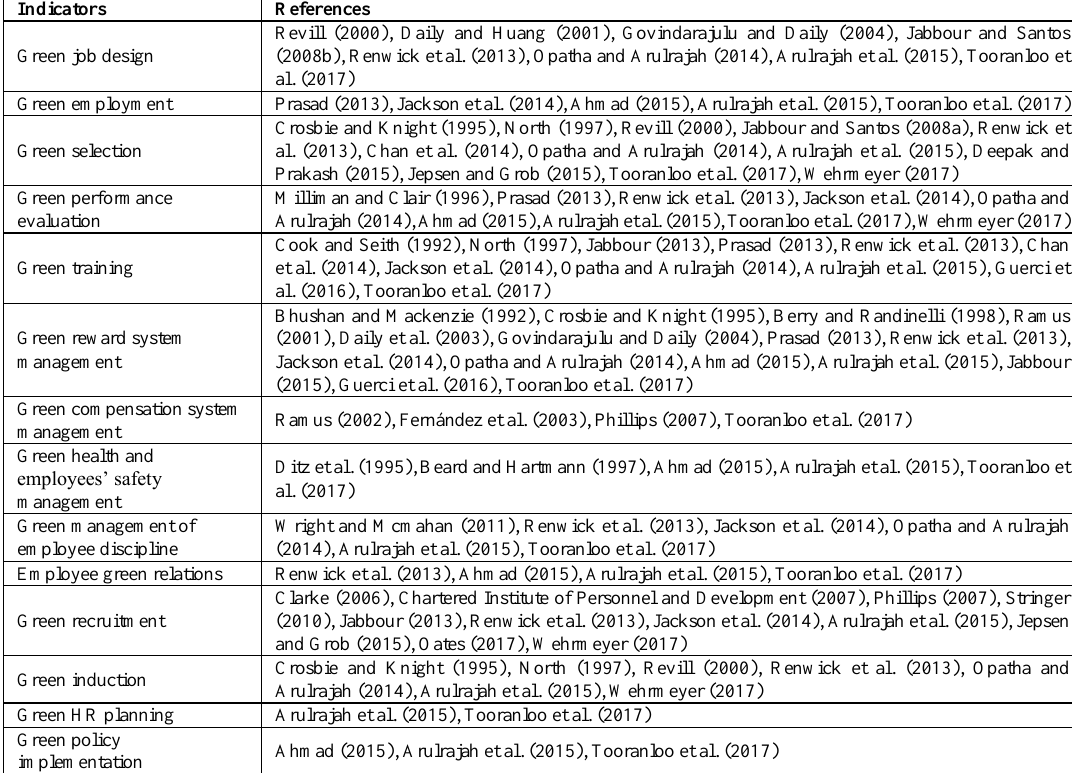
Table 3. Environmental sustainability indicators of